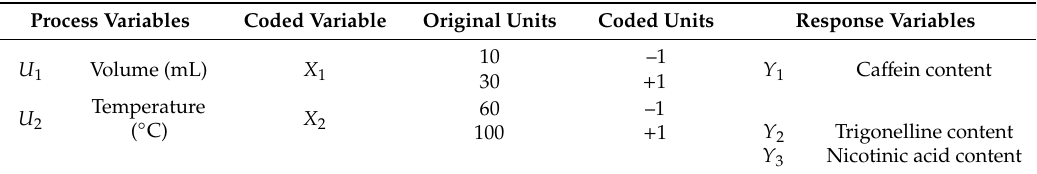
Table 2. Process variables, along with the corresponding tested levels (lower and upper level) and the three response variables under study for the extraction optimization from spent co ff ee.